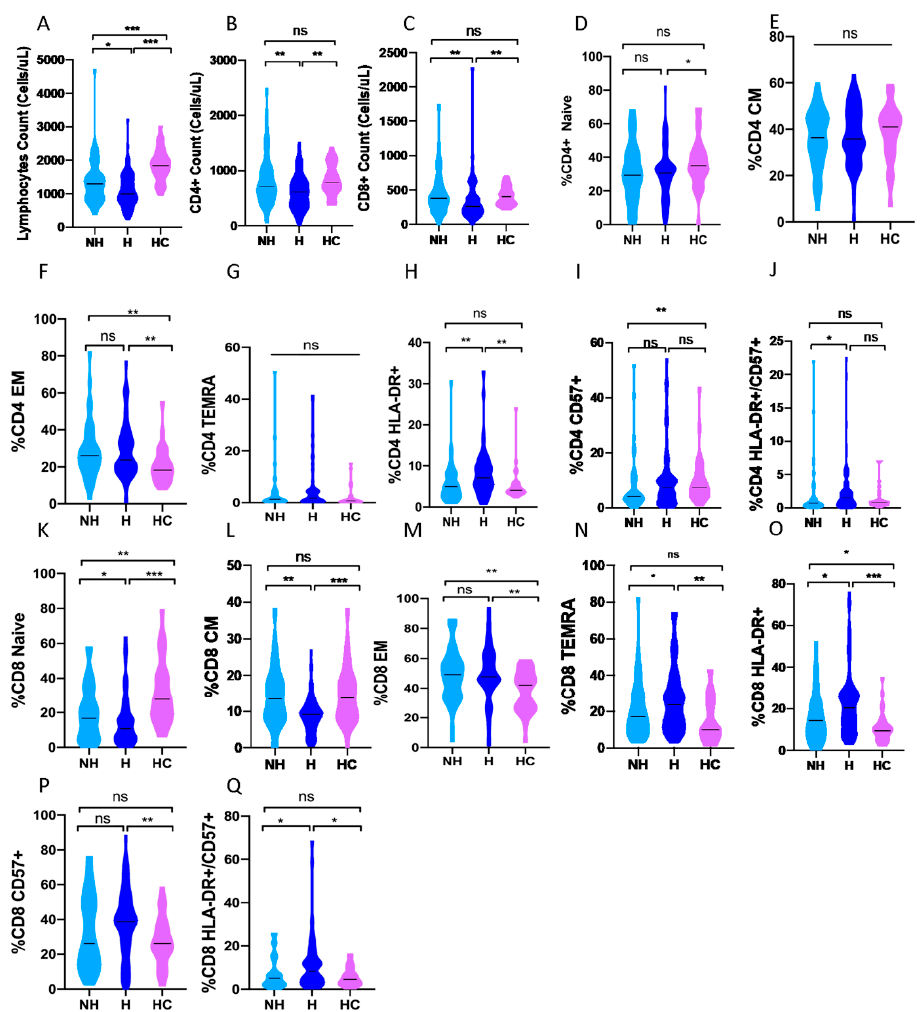
Figure 3. Differences in lymphocyte subsets between healthy controls, non-hospitalized and hospitalized COVID-19 patients separately. ( A ) Lymphocyte count (cells/ µ L) ( B ) Number of CD4+ (cells/ µ L) T cells ( C ) Number of CD8+ (cells/ µ L) T cells ( D ) Percentage of naive (CCR7+/CD45RA+) CD4+ T cells ( E ) Percentage of CM (central memory, CCR7+/CD45RA-) CD4+ T cells ( F ) Percentage of EM (effector memory, CCR7-/CD45RA-) CD4+ T cells ( G ) Percentage of TEMRA (Terminal differentiated T memory cells, CCR7-/CD45RA+) CD4+ T cells ( H ) Percentage of activated (HLA-DR+) CD4+ T cells ( I ) Percentage of senescent (CD57+) CD4+ T cells ( J ) Percentage of double positive (HLA-DR+/CD57+) CD4+ T cells ( K ) Percentage of naive (CCR7+/CD45RA+) CD8+ T cells ( L ) Percentage of CM (central memory, CCR7+/CD45RA-) CD8+ T cells ( M ) Percentage of EM (effector memory, CCR7-/CD45RA-) CD8+ T cells ( N ) Percentage of TEMRA (Terminal differentiated T memory cells, CCR7-/CD45RA+) CD8+ T cells ( O ) Percentage of activated (HLA-DR+) CD8+ T cells ( P ) Percentage of senescent (CD57+) CD8+ T cells ( Q ) Percentage of double positive (HLA-DR+/CD57+) CD8+ T cells. NH; Non-hospitalized COVID-19 patients, H; Hospitalized COVID-19 patients, HC; Healthy controls. ns, not-significant; * p < 0.05; ** p < 0.01; *** p < 0.001.